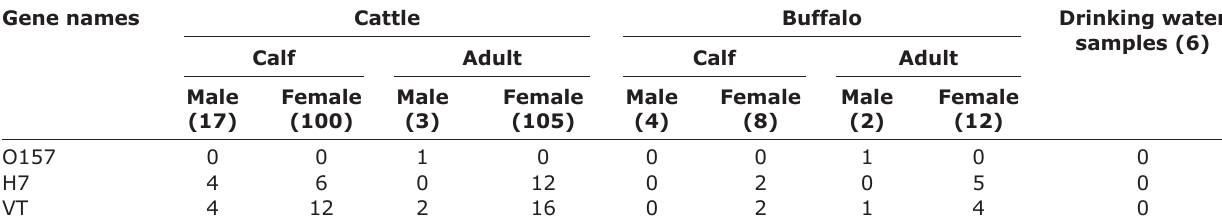
Table-3: Polymerase chain reaction screening for three different verotoxin-producing genes (O157, H7, and VT) in Escherichia coli isolates from cattle and